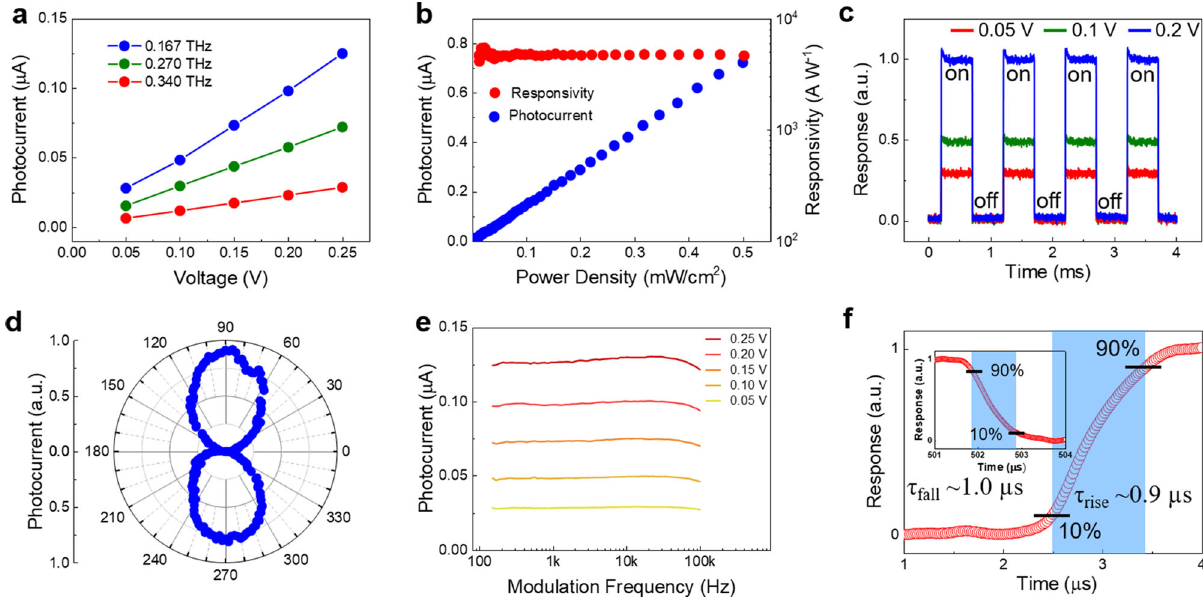
Fig. 4 The performance of the detector in the THz and MMW bands. a Photocurrent of the detector under different bias at 0.167 THz, 0.270 THz and 0.340 THz. b Dependence of the photocurrent and the responsivity on the radiation intensity at 0.03 THz. c Time-resolved measurements at 0.167 THz with different bias voltage of 50 mV, 100 mV and 200 mV. d Polarization dependence of the detector at 0.167 THz. e Photoresponse of the detector under different bias voltage and modulation frequency. f Shows the rising edge and falling edge of the photoresponse in a single